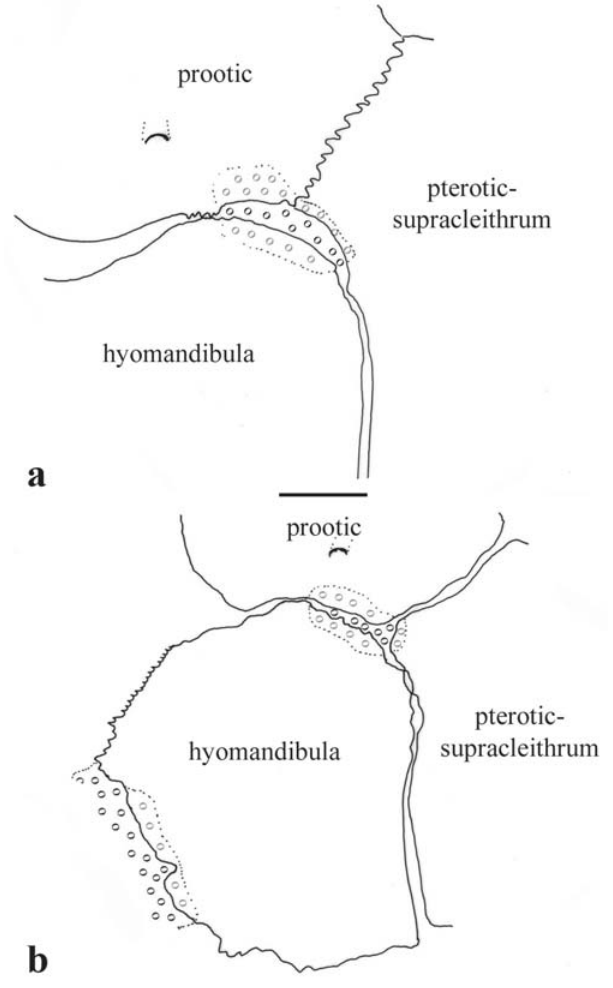
Fig. 33. Ventral view of the suspensorium-neurocranium articulation of Lamontichthys filamentosus (LACM 41741-9, 119.4 mm SL) (a) and Pterosturisoma microps (MZUSP 79909, 75.9 mm SL) (b). Scale bar = 1